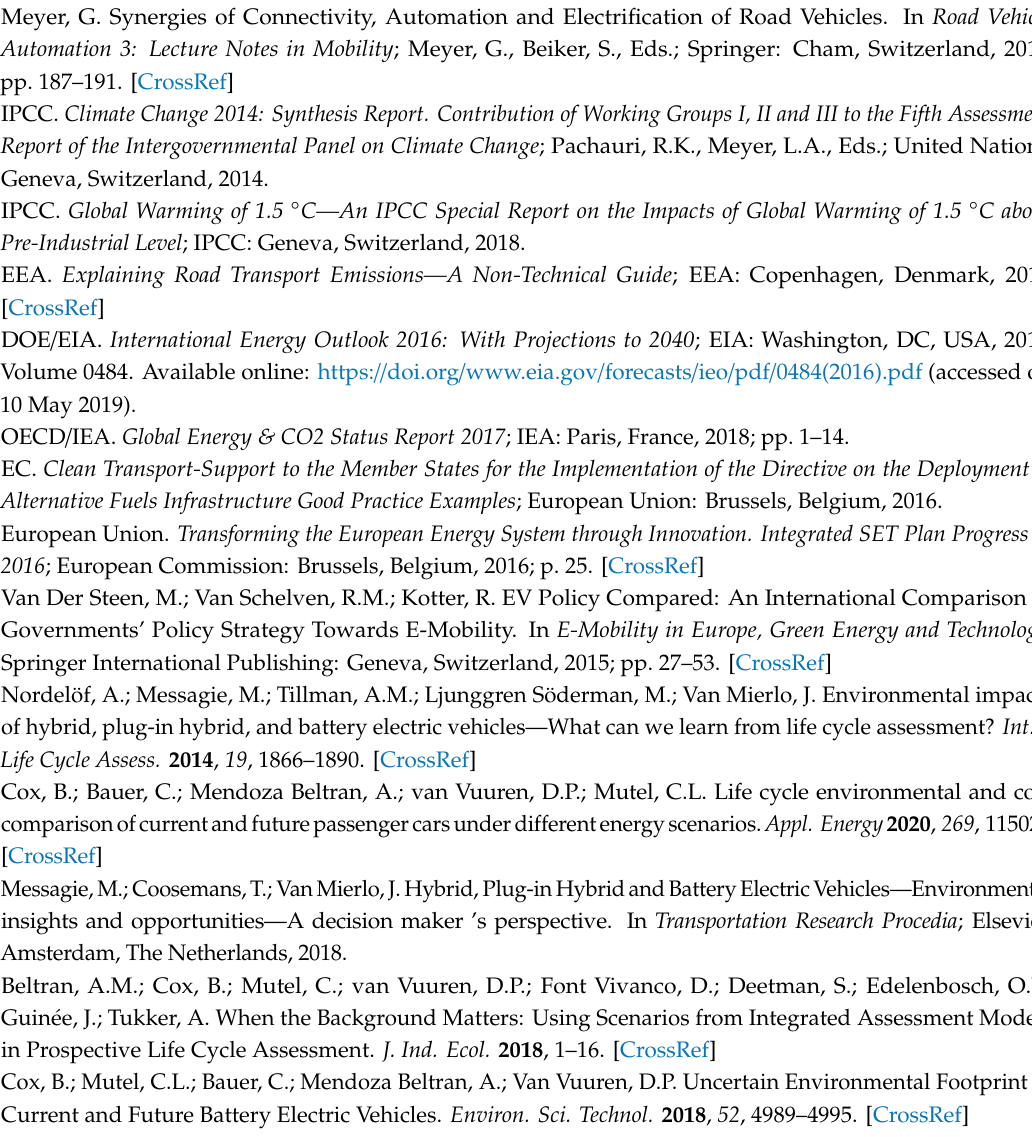
Figure S1: Prospective life cycle assessment results of impact categories for which BEV performed better than ICEV, Figure S2: Prospective life cycle assessment results of impact categories for which BEV performed worse than ICEV with no improvement in future BEV, Figure S3: Prospective life cycle assessment results of impact categories for which BEV performed worse than ICEV but shows improvement in future scenarios compared to the reference case BEV, Figure S4–Figure S7: Prospective environmental impacts of vehicle production considering advances in future steel and electricity